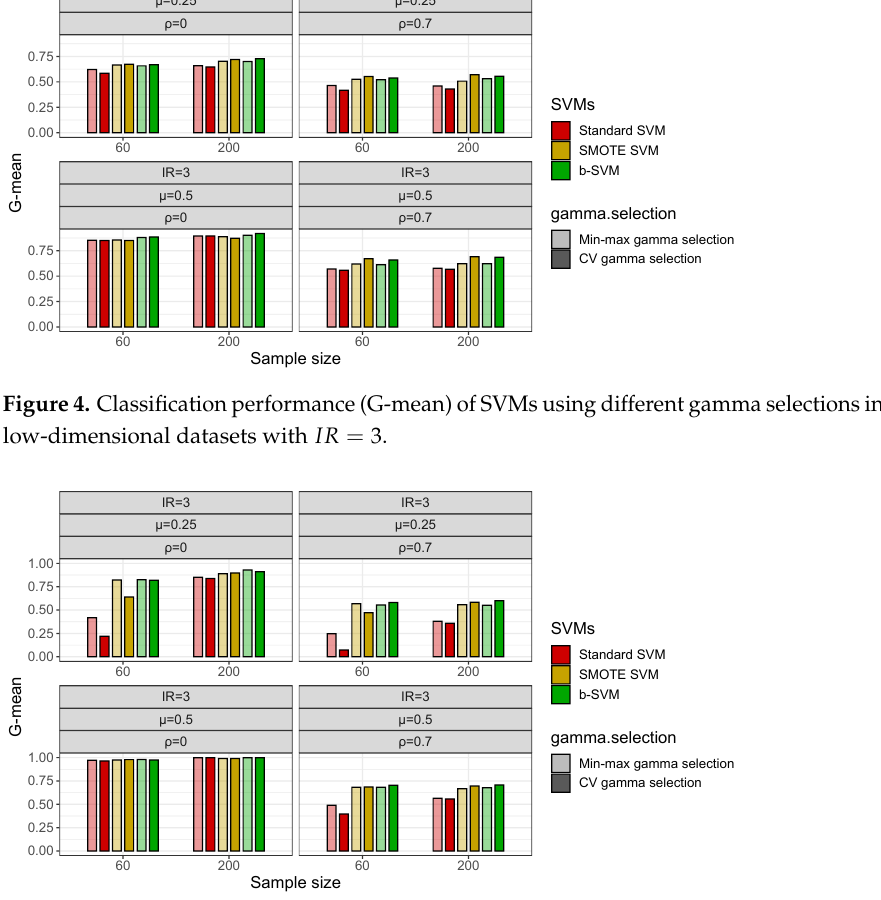
Figure 5. Classification performance (G-mean) of SVMs using different gamma selections in simulated high-dimensional datasets with IR = 3. Table 3. Completion time (s) of SVMs using different gamma selections in simulated low datasets.